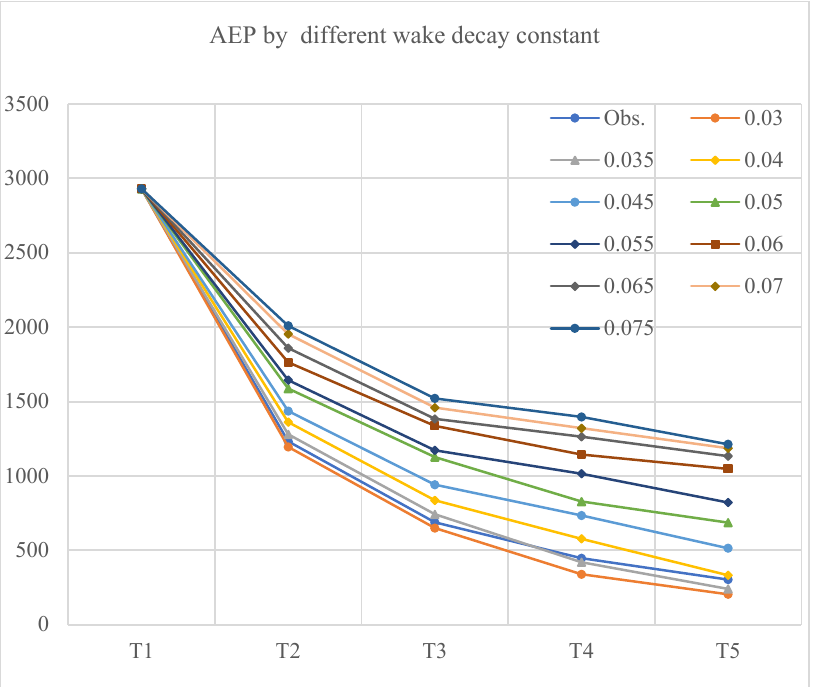
Figure 12. AEP by different wake decay constant.